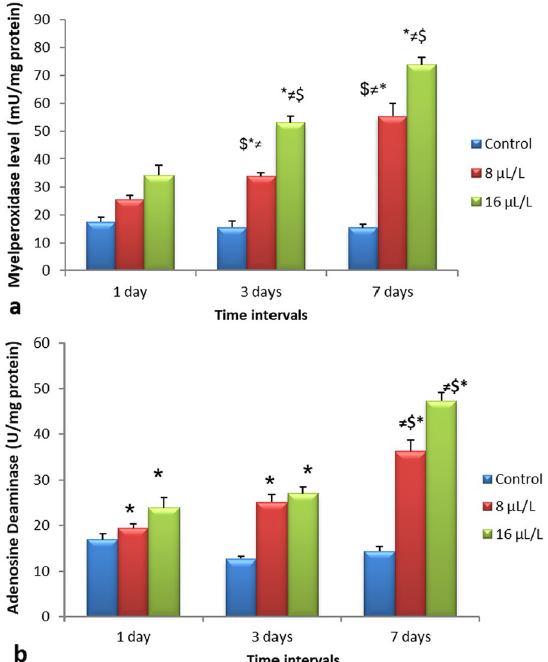
Fig. 3 The effect of different concentrations of RIPEX on immune potential enzymes in digestive glands of Biomphalaria alexandrina . a : myeloperoxidase (MPO) activity. b : adenosine deaminase (ADA) activity. Values are expressed as mean SD. Significance difference ± as compared to control (*) and between different concentrations ( ≠ ) and ( $ ) between the time intervals, p 0.05 ≤